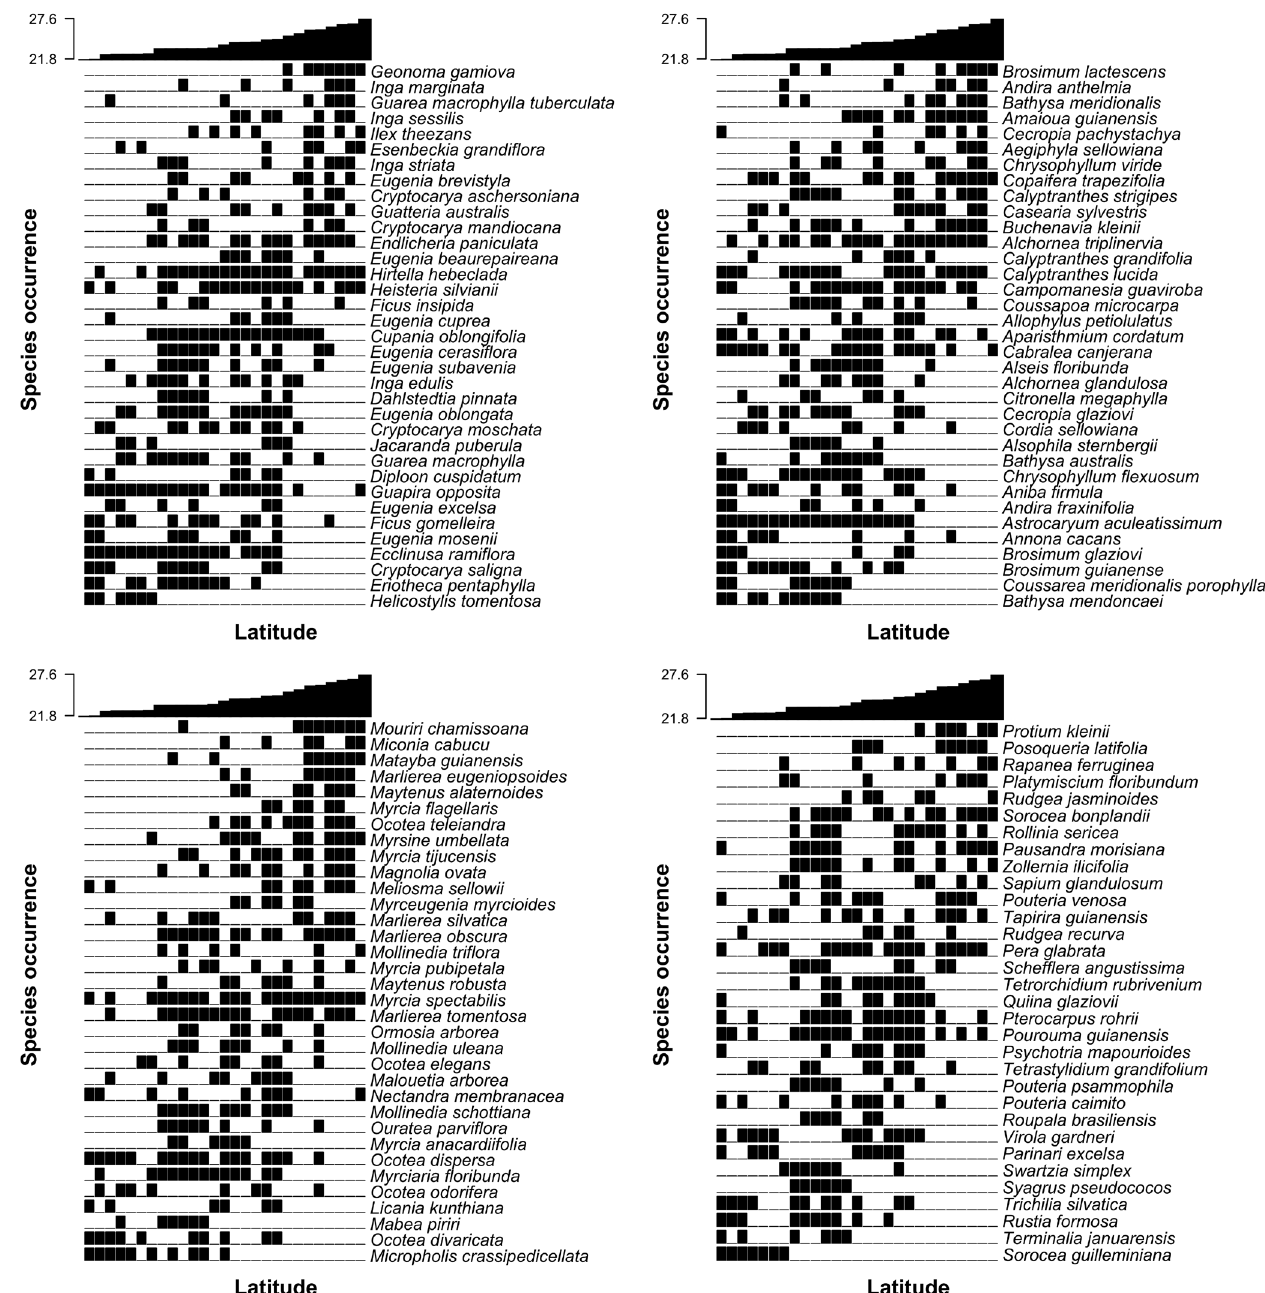
Figure 2 – Pattern of species substitution revealed by the analysis of species ordination along the latitudinal gradient (21°S to